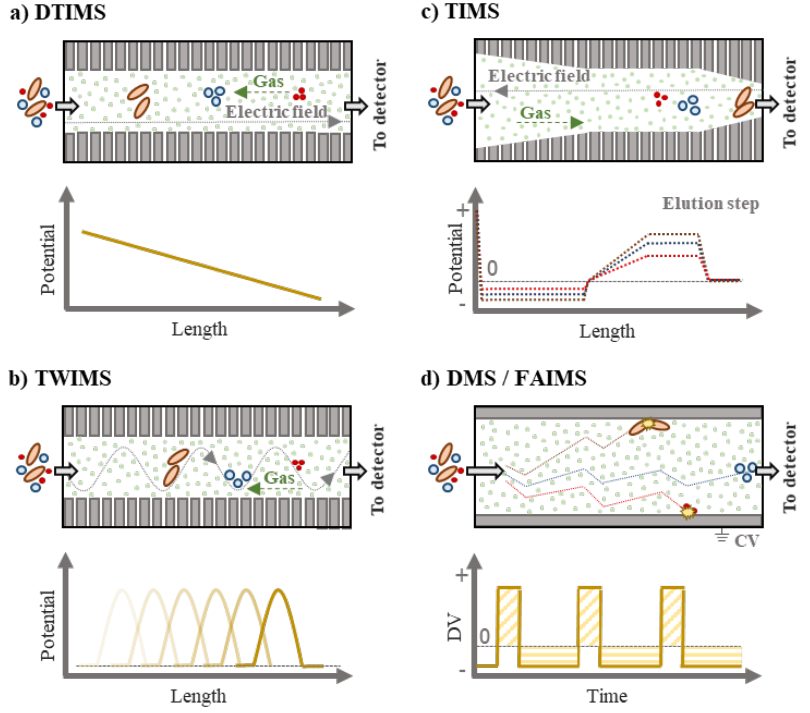
Figure 2. Schematic representation of commercially available IMS forms.